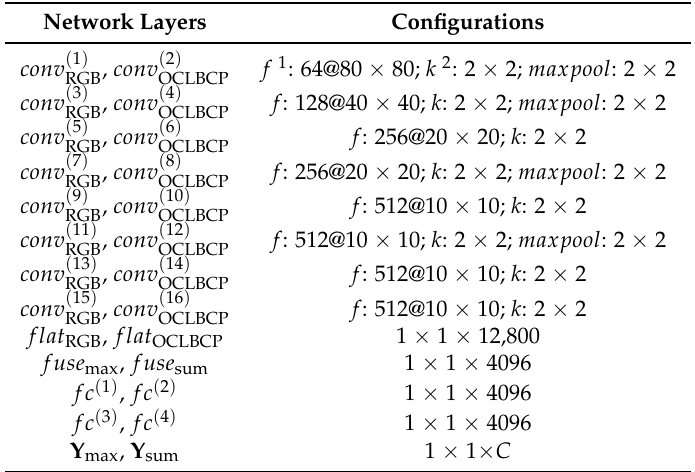
Table 1. Configurations of each layer for the proposed